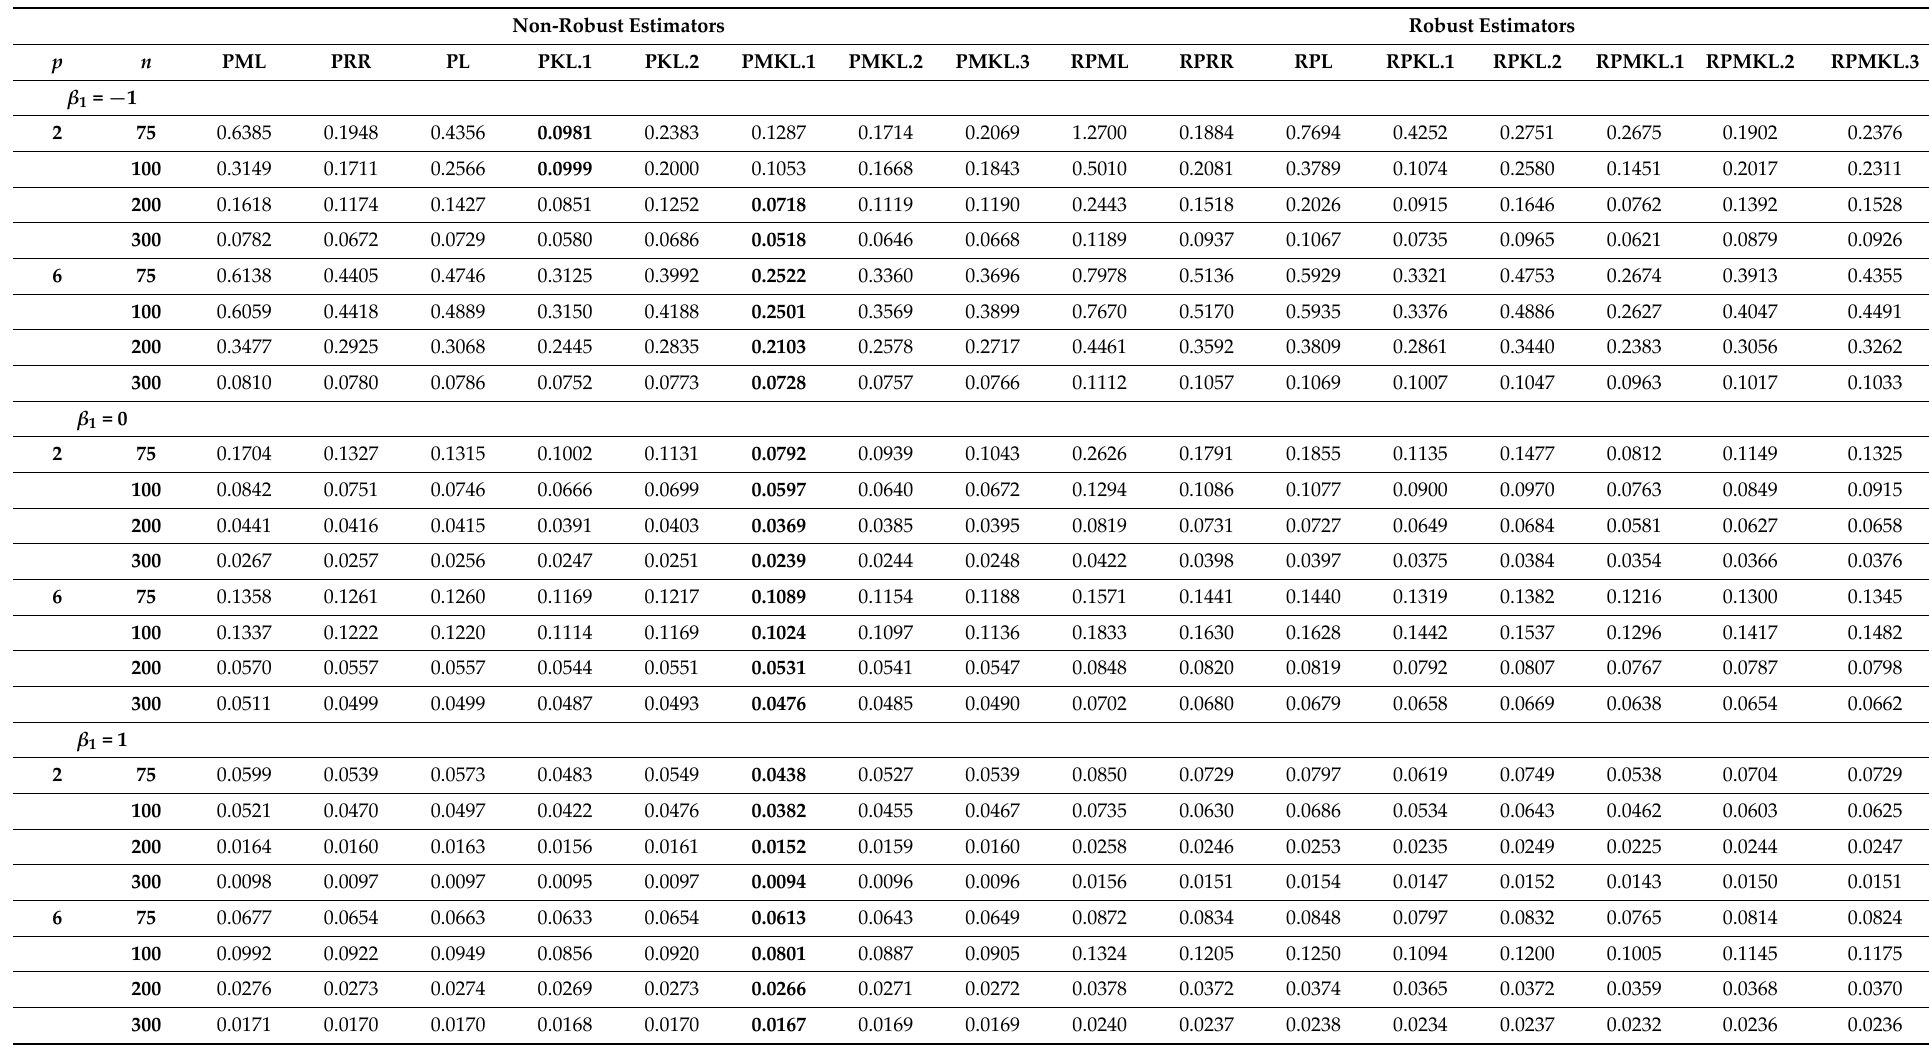
Table A2. AMSE of different estimators when τ = 0% and ρ =